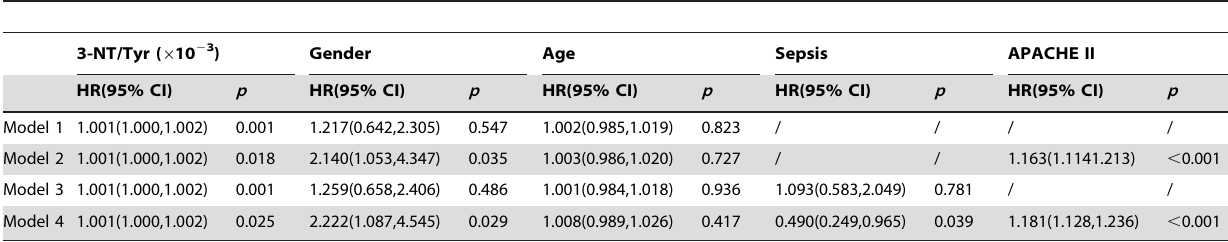
Table 2. Multivariate Cox regression analysis for 3-NT/Tyr and other selected possible predictors of mortality in patients with